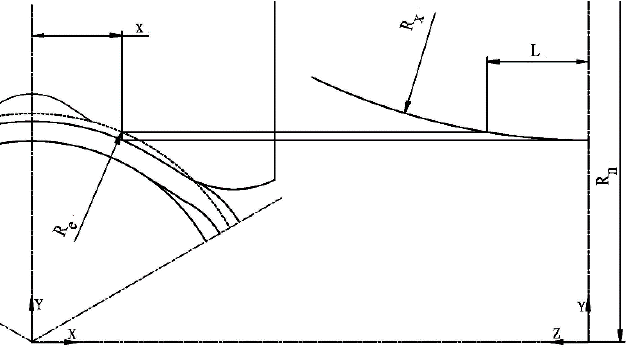
Figure 3. Geometrical relationship for the contact length corresponding to the second formation stage.